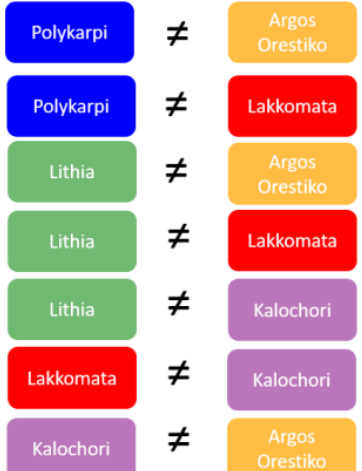
Figure 9 . Statistically significant results of soil texture (categorical data; soil texture classes).